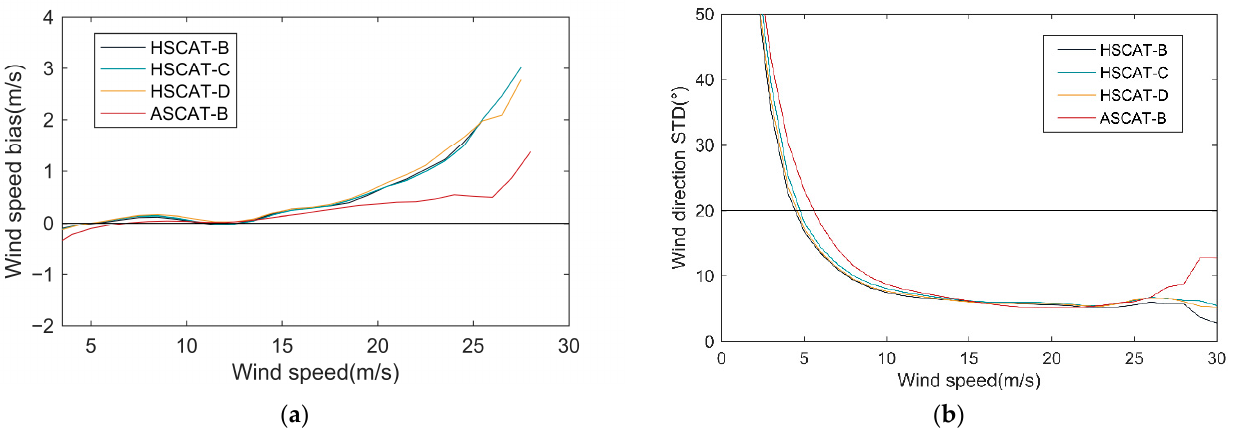
Figure 5. Scatterplots of wind spee d ( a ) and direction ( b ) derived from HSCAT-D versus ECMWF winds.